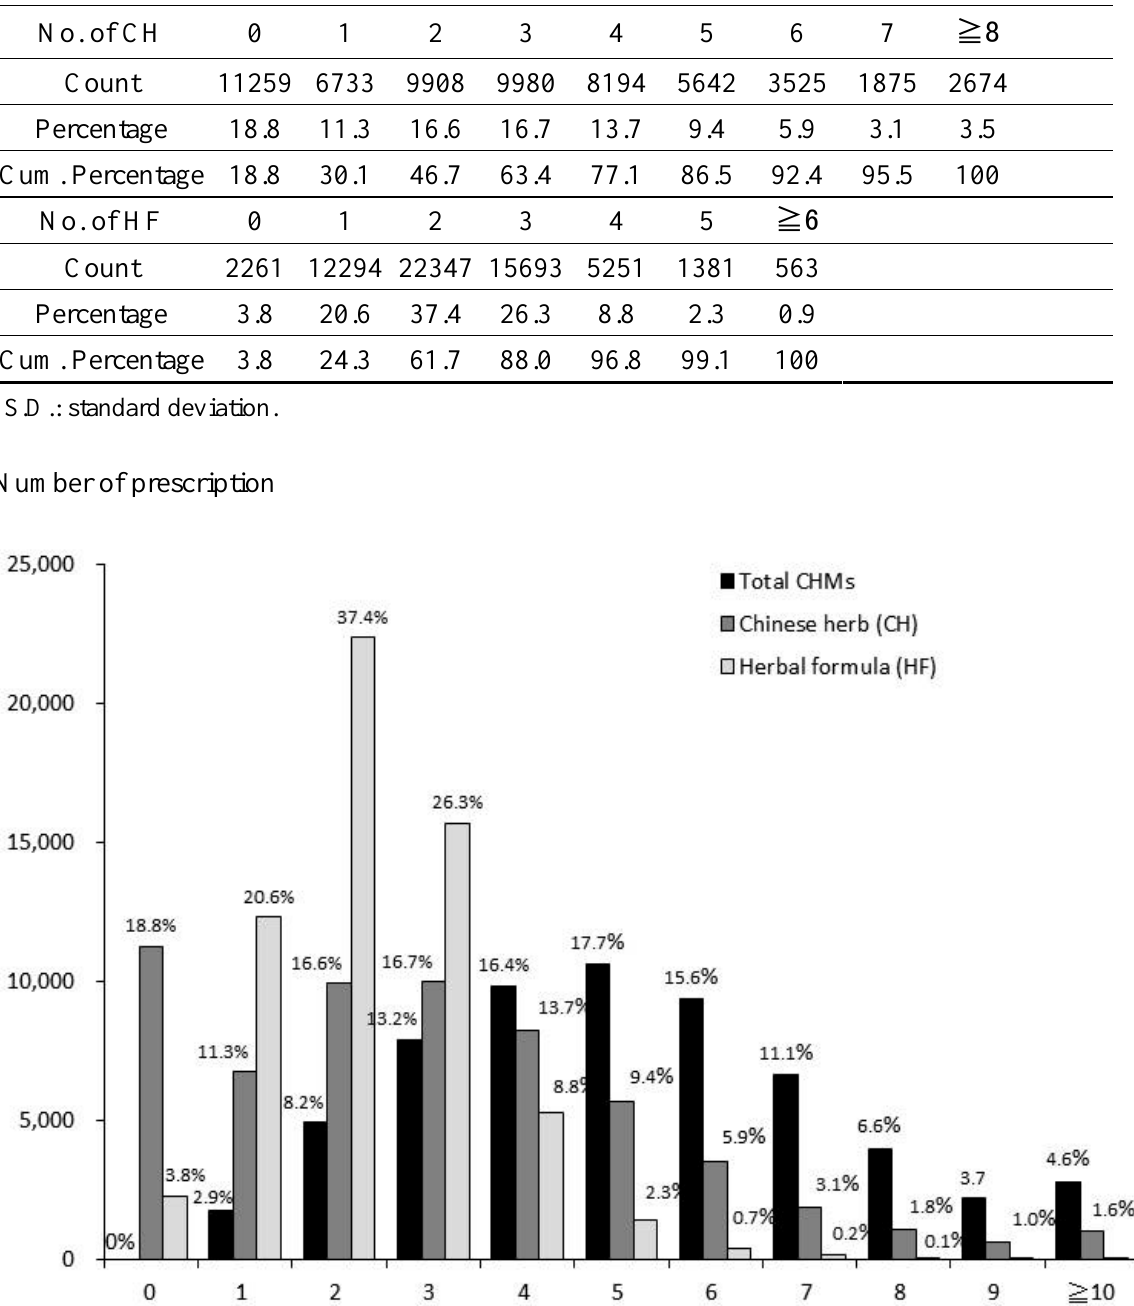
Figure 1. Number of CHMs (Chinese herbs and/or herbal formulas) in a single